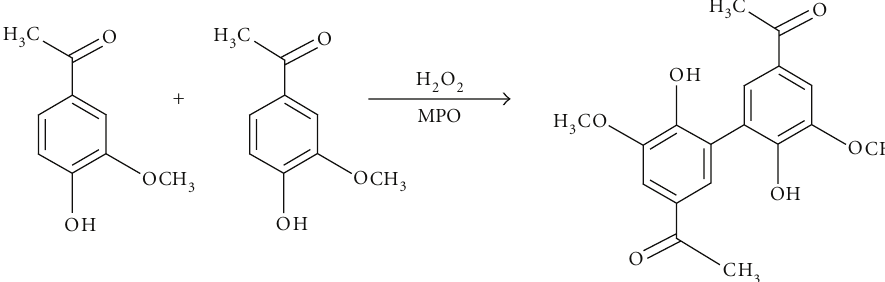
Figure 1: Creating active form of apocynin-dimerization.